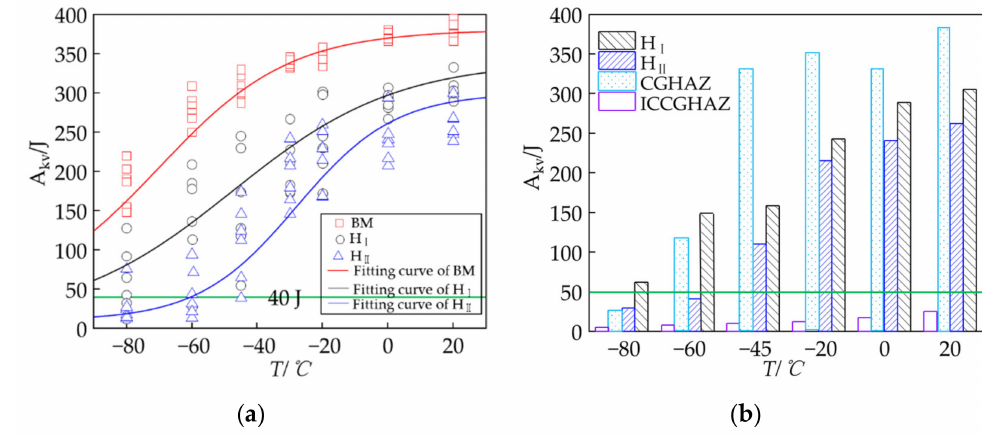
Figure 5. The impact absorbed energy of different zones: ( a ) single value; ( b ) mean